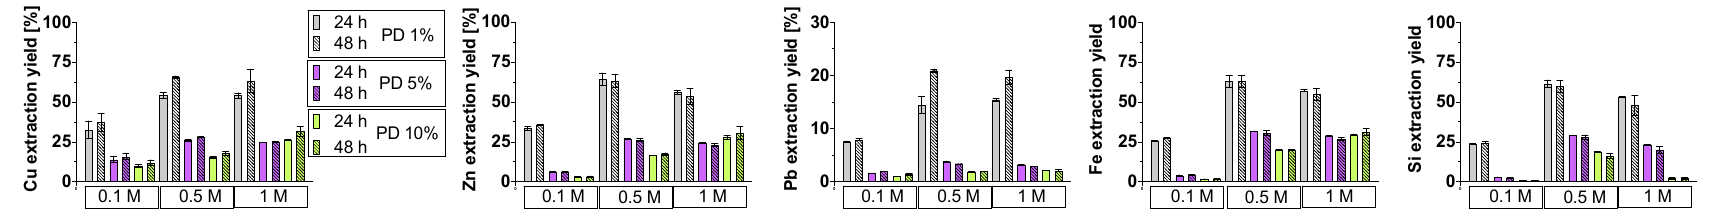
Figure 5. Chemical extraction of metals from amorphous slag treated with normality equivalent (2 N) acids at various pulp densities (1–2%).